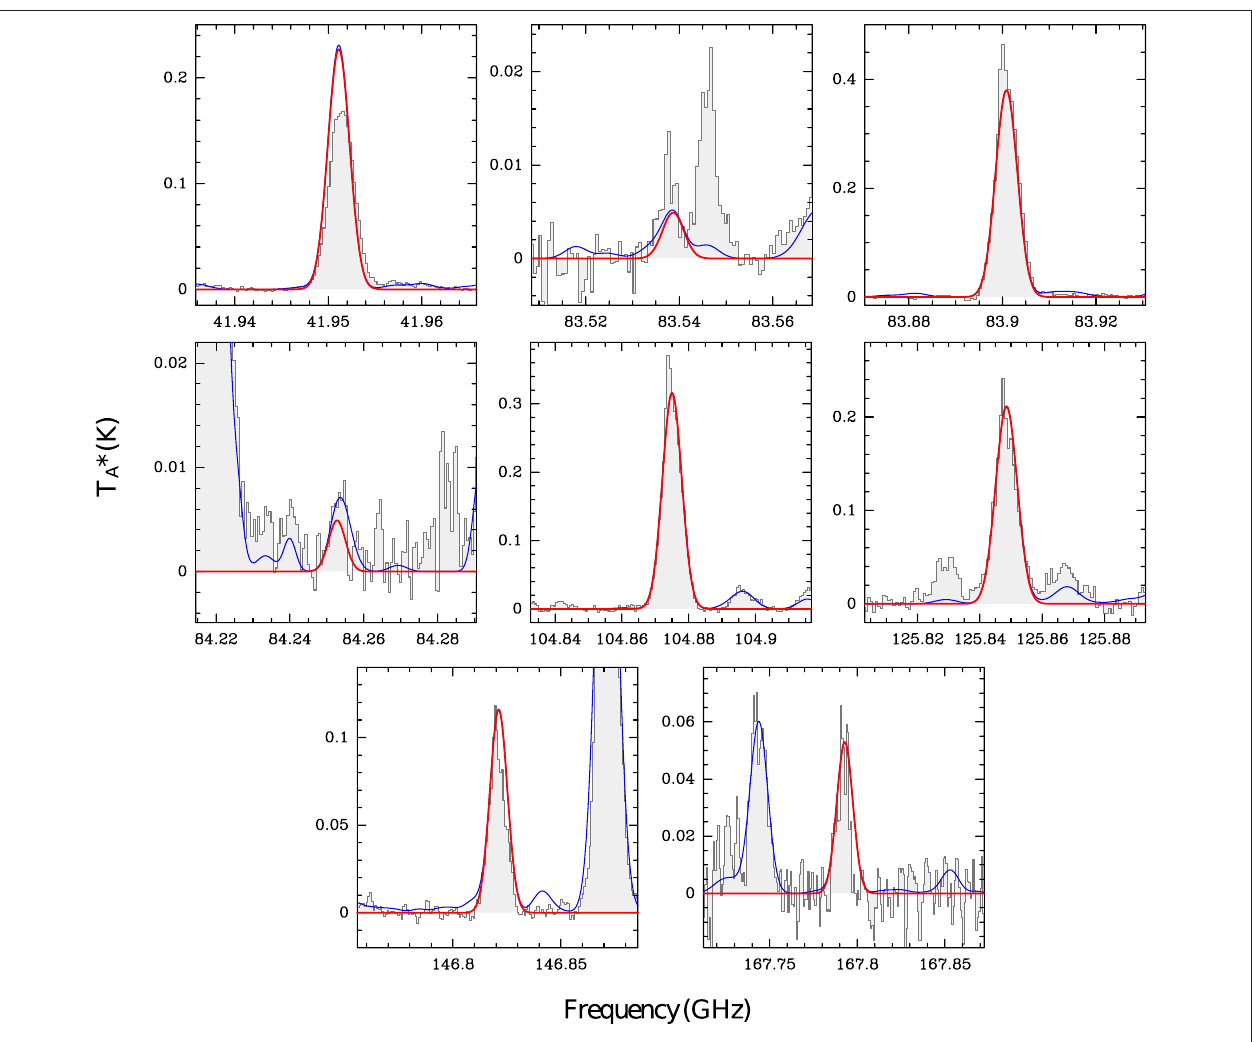
FIGURE2| Selectedcyanicacid(HOCN)transitions(see Table2 )detectedtowardstheG+0.693molecularcloud.ThebestLTE fi tderivedwithMADCUBAforthe HOCN emission is shown with a red curve, while the blue curve shows the total emission considering all the species identi fi ed towards this molecular cloud. The y-axis shows the line intensity in antenna temperature scale ( T A * ) in Kelvin, and the x-axis shows the frequency in GHz.